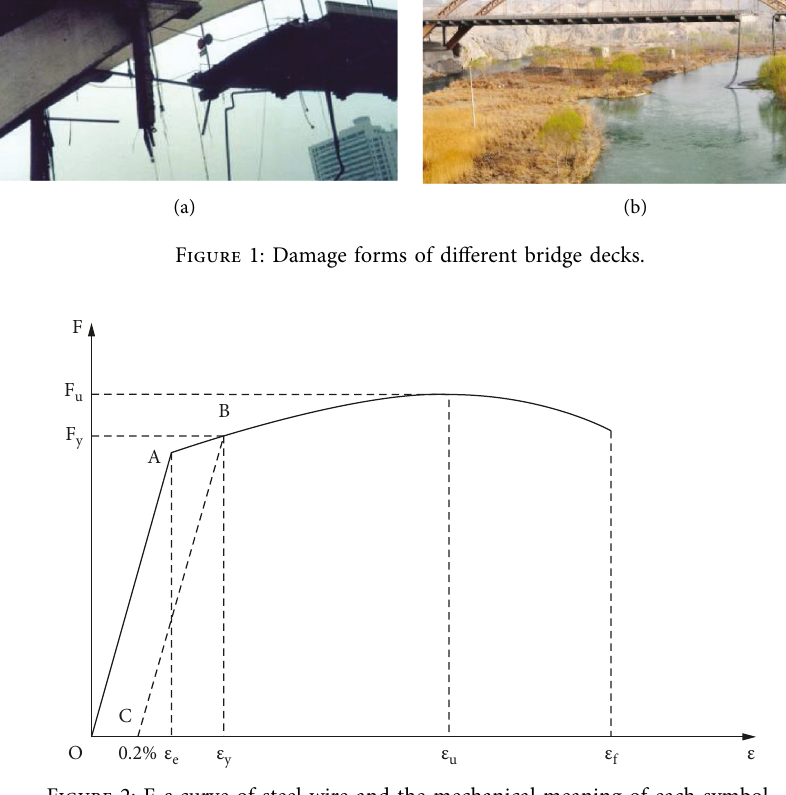
Figure 2: F- ε curve of steel wire and the mechanical meaning of each